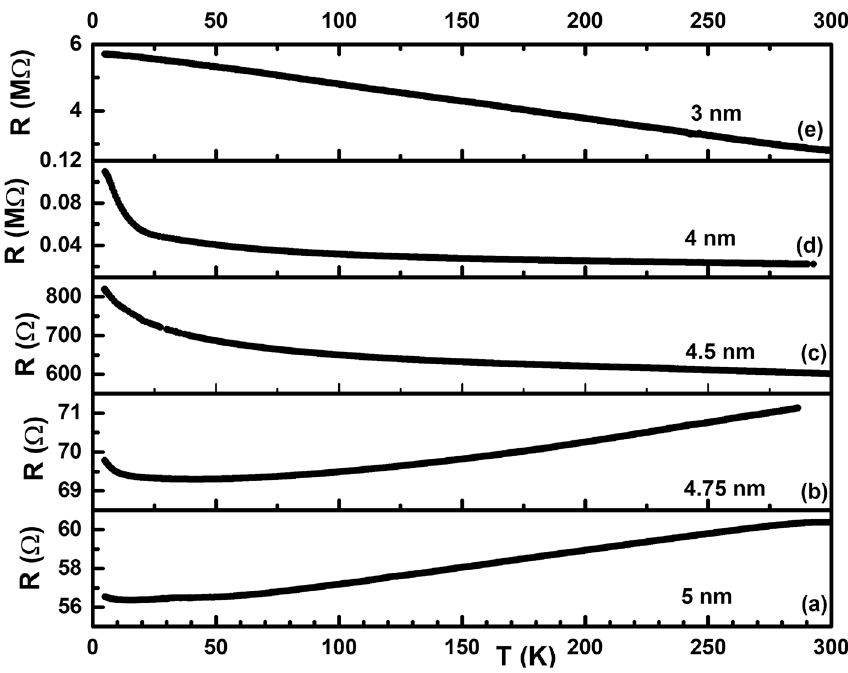
Figure 5. Temperature variation of resistance in films of thickness ( a ) 5 nm, ( b ) 4.75 nm, ( c ) 4.5 nm, ( d ) 4 nm and ( e ) 3